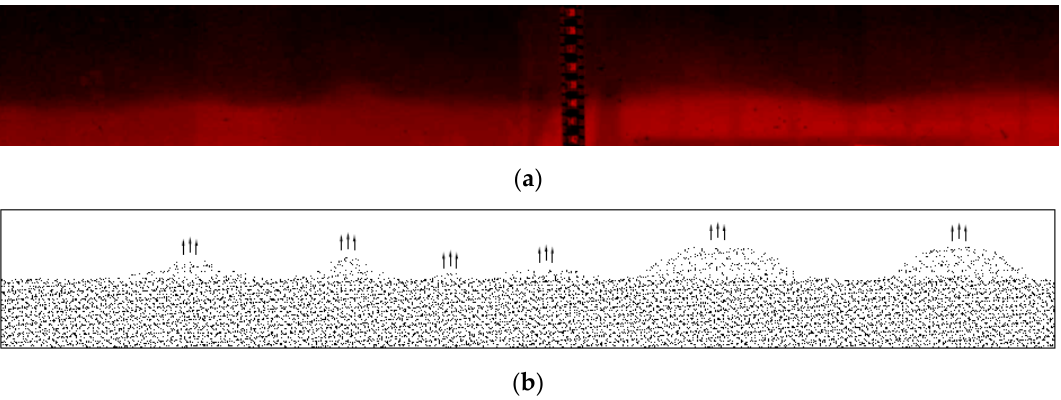
Figure 6. Lateral photograph of a salt-fresh water interface which showed K-H instability. (a) Processed image. A small amount of colored water diffused into the upper colorless water at the wave peak. (b) Schematic diagram of Figure 5(a) for represent the salinity diffusion.